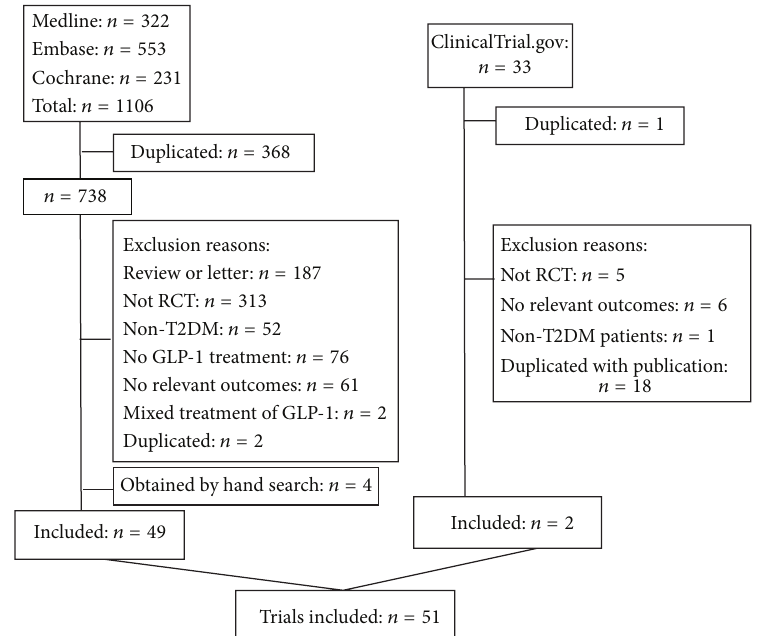
Figure 1: Flowchart of inclusion and